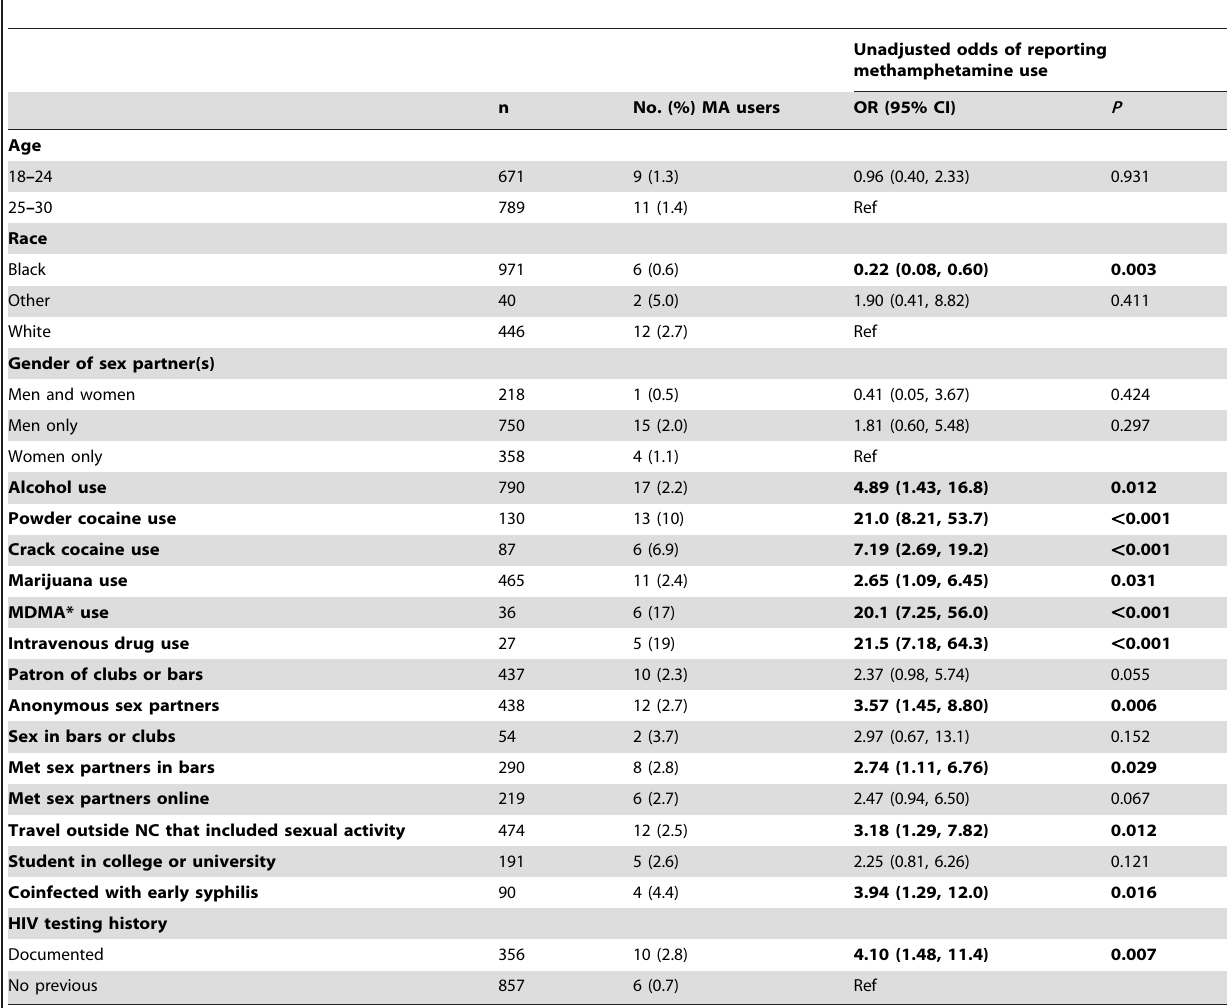
Table 1. Bivariate analyses of factors associated with methamphetamine use among 1,460 men aged 18–30 diagnosed with HIV in North Carolina, 2000 to 2005.